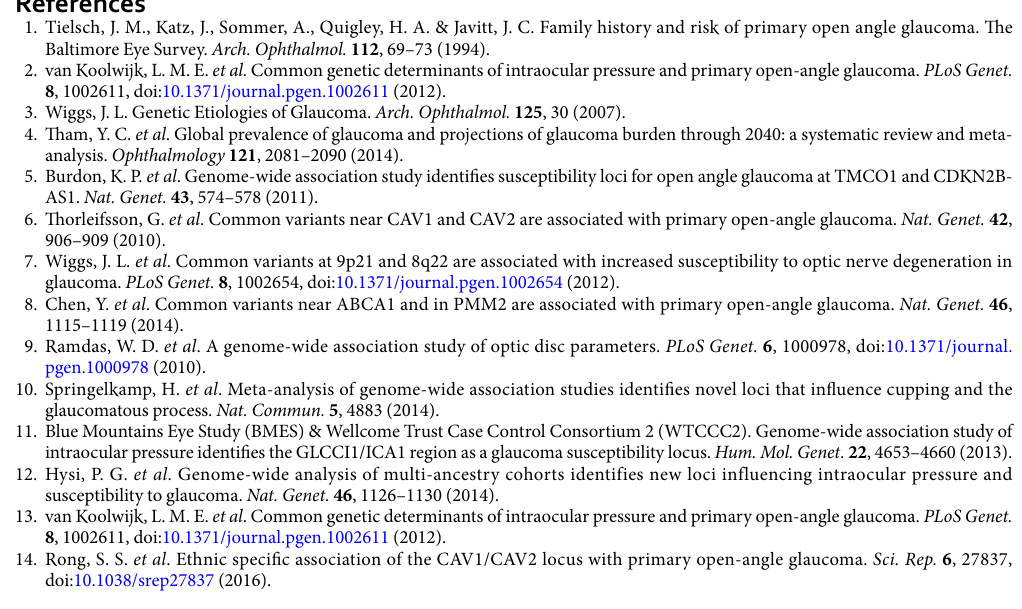
Statistical analysis. Linear regression analyses were performed to determine the associations between regional cpRNFLT and the 26 SNP genotypes assuming additive regression models for a per-minor-allele with an adjustment for age, sex, and axial length. We evaluated regional cpRNFLT associations using 4 divided sectors and finer 32 sectors with Bonferroni corrections. P values < 6.0 × 10 − 5 (0.05/26 SNPs/32 sectors) and < 4.8 × 10 − 4 (0.05/26 SNPs/4 sectors) were considered statistically significant for cpRNFL in the 32-sector and 4-sectors analy- ses, respectively, whereas P-values < 0.0016 (0.05/32 sectors) and < 0.0125 (0.05/4 sectors) were considered mar- ginally significant, respectively.